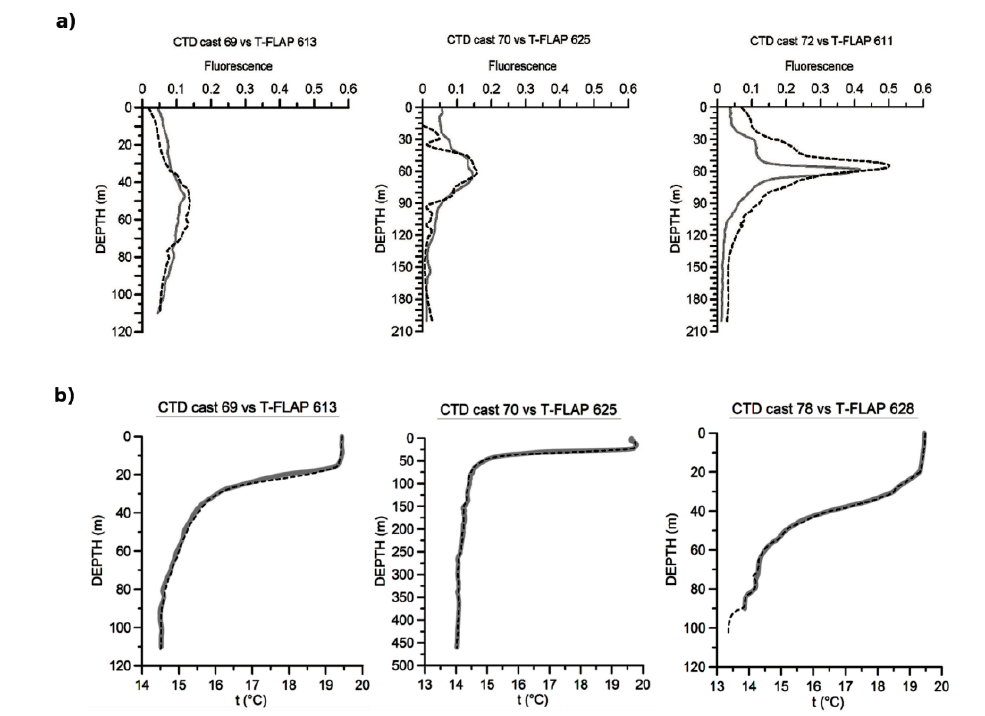
Figure 9. ( a ) Comparison between T-FLaP (dashed dark line) and Chelsea Aquatraka III (solid grey line) fluorescence profiles and ( b ) Comparison between T-FLaP (dashed dark line) and SBE911 (solid grey line) temperature